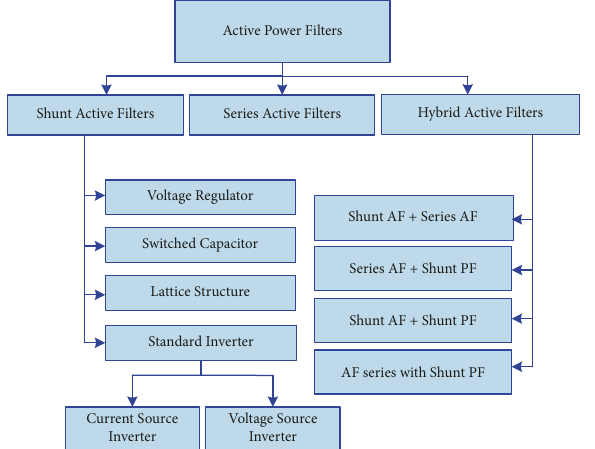
Figure 4: APF classification on the basis of circuit